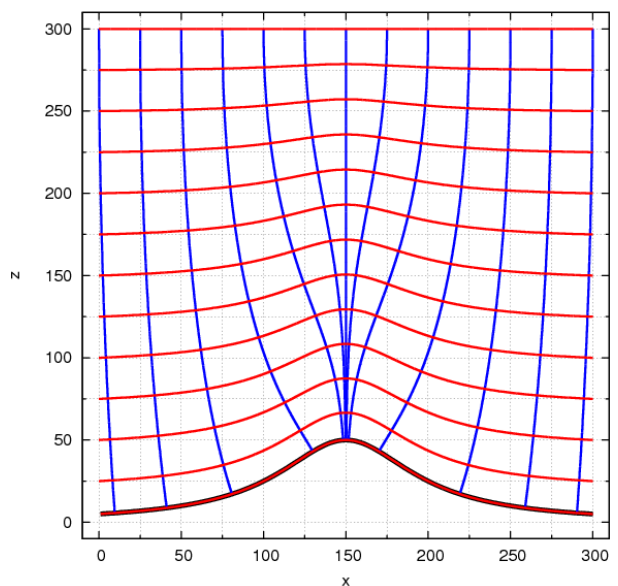
Figure 3. The 2-D grid of the OS coordinate. The red lines are the σ levels, the blue lines are the x 0 levels, and the black curve represents the